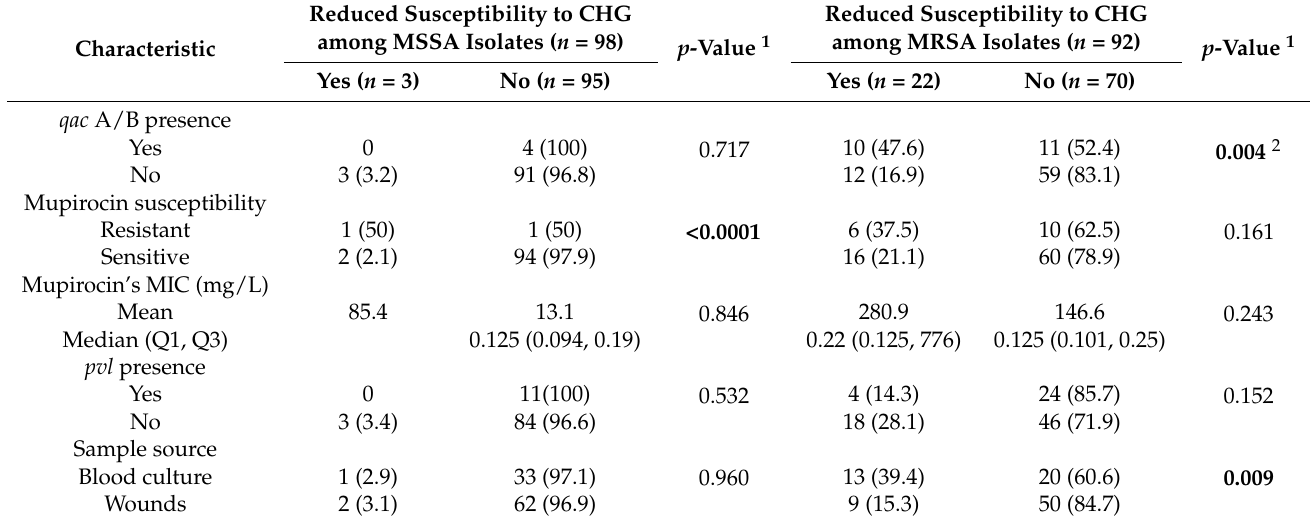
Table 4. Clinical and epidemiological characteristics of CHG-tolerant isolates vs. CHG-susceptible MSSA and MRSA isolates.